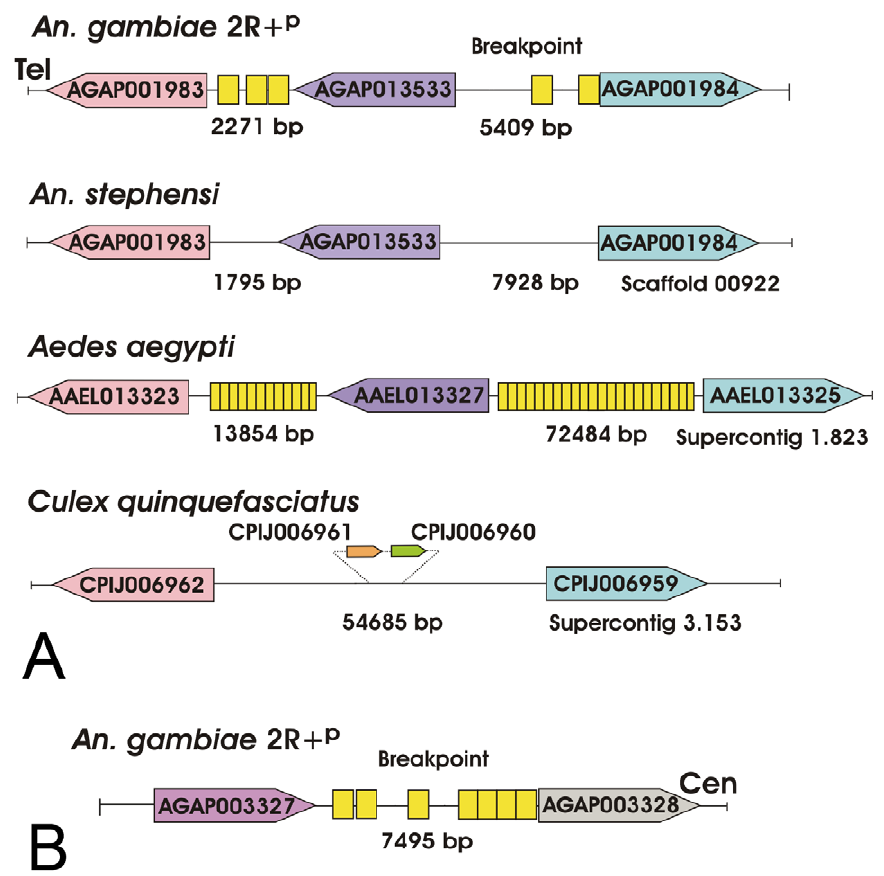
Figure 6. Gene order in assembled sequences of the 2R + p breakpoints. Genes of An. gambiae as well as three outgroup species An. stephensi , Ae. aegypti , and C. quinquefasciatus are shown. ( A ) The distal 2R + p breakpoint region. Distances between genes are indicated in base pairs, and they are not depicted proportionally. Homologous genes are shown in their 5 9 -3 9 orientation with boxes of similar colors. Additional genes at the breakpoint of C. quinquefasciatus are shown in a smaller scale. Yellow boxes show assemblies of degenerate TEs. In An. gambiae , TEs are shown in the following order from left to right: SINEX-1_AG, P4_AG, SINEX-1_AG, RTE-1_AG, and SINEX-1_AG. ( B ) The proximal 2R + p breakpoint region. The An. stephensi , Ae. aegypti , and C. quinquefasciatus genes homologous to genes from the proximal 2R + p breakpoint of An. gambiae are found in different scaffolds and supercontigs and, therefore, are not shown. In An. gambiae , TEs are shown in the following order from left to right: AARA8_AG, CR1- 8_AG, Copia-6_AG-LTR, Clu-47_AG, Clu-47_AG, SINEX-1_AG, and Clu-47_AG. The sizes of genes and intergenic regions are not drawn to scale. The correct orientation of genes with respect to the centromere (Cen) and telomere (Tel) is shown only for An. gambiae .